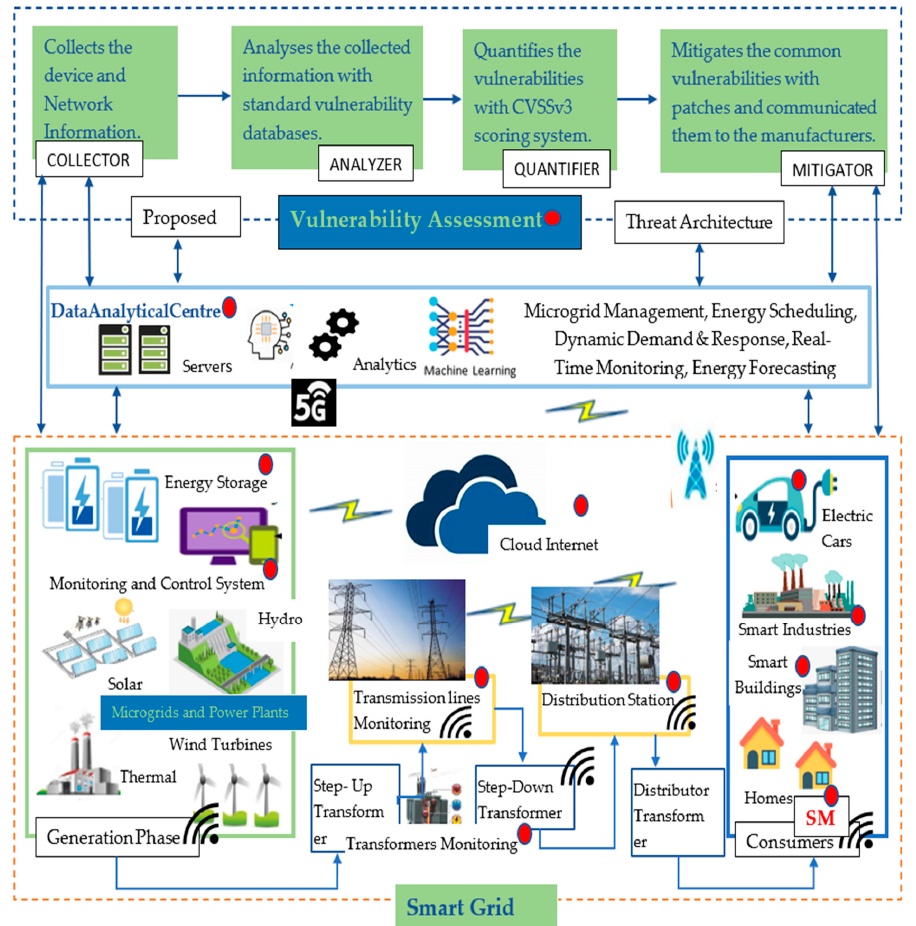
Figure 8. Secure Energy Management in Smart Grid [58–64].